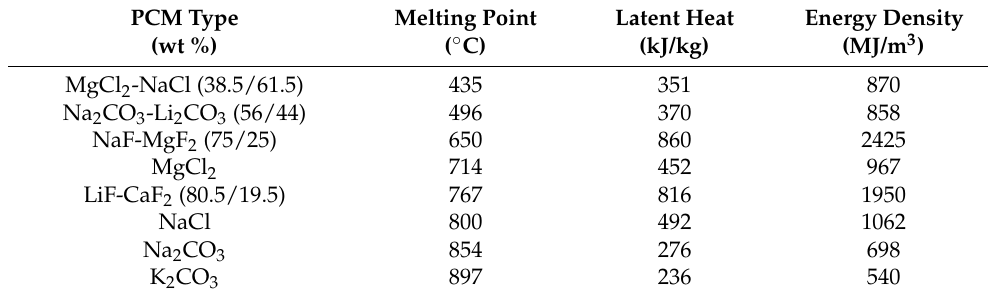
Table 2. Inorganic PCMs with melting temperature above 400 ◦ C, latent heat and energy